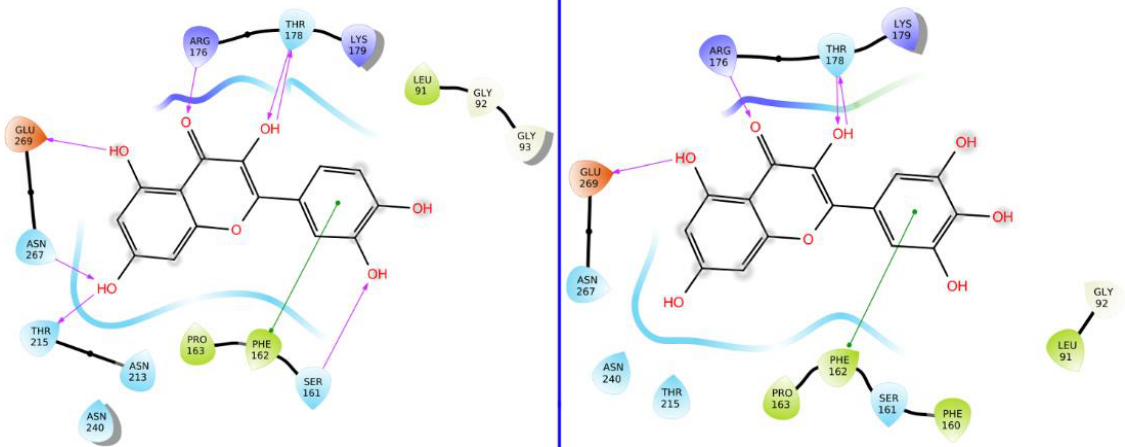
Figure 4. The 2D interaction models of quercetin ( left ) and myricetin ( right ). Quercetin exhibited hydrogen bonds with Ser161, Arg176, Thr178, Thr215 and